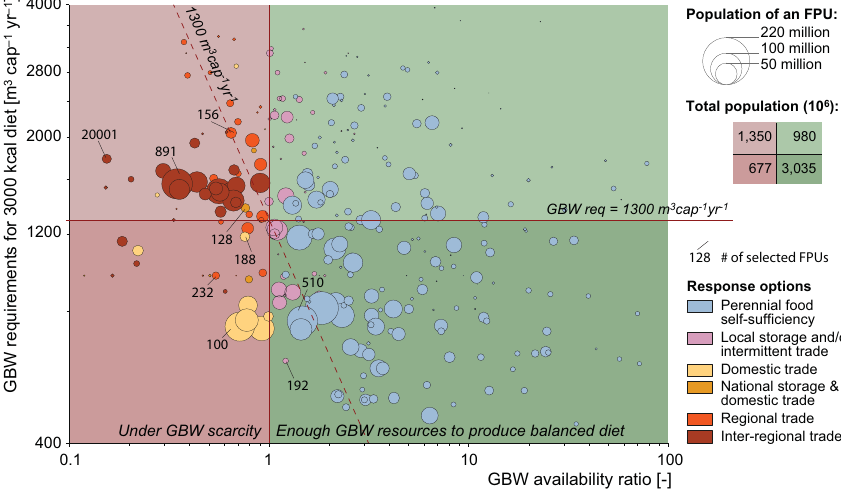
Fig. 6. FPUs mapped in the GBW matrix, grouped by response options. The location of an FPU is based on green-blue water (GBW) requirements for the reference diet ( y axis) and GBW availability ratio ( x axis; i.e. GBW availability vs GBW requirements) under average climate conditions. Thus, the FPUs with response option of “local storage and/or intermittent trade” are under occasional scarcity although not under average GBW scarcity. The dashed red line represents the threshold for GBW scarcity in Rockström et al. (2009), i.e. GBW availability of 1300m 3 cap − 1 yr − 1 , and thus provides a comparison to their method. See Table 2 for more information of these options, and Fig. S2 in Supplement for the concept of the GBW matrix. The selected FPUs are identified with their code; see Fig. 5 for their location in a map. Note: log10 scale in both